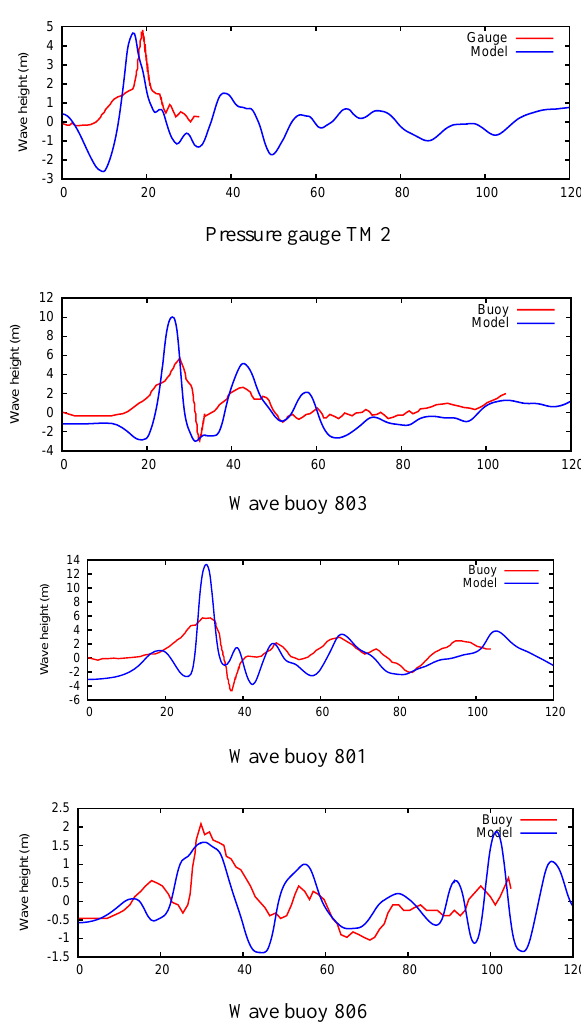
Fig. 17. Comparison between recorded and modelled wave ampli- tudes for the inshore locations indicated in Fig. 5. The stations are ordered by latitude from top to bottom. The horizontal axis is time in minutes.